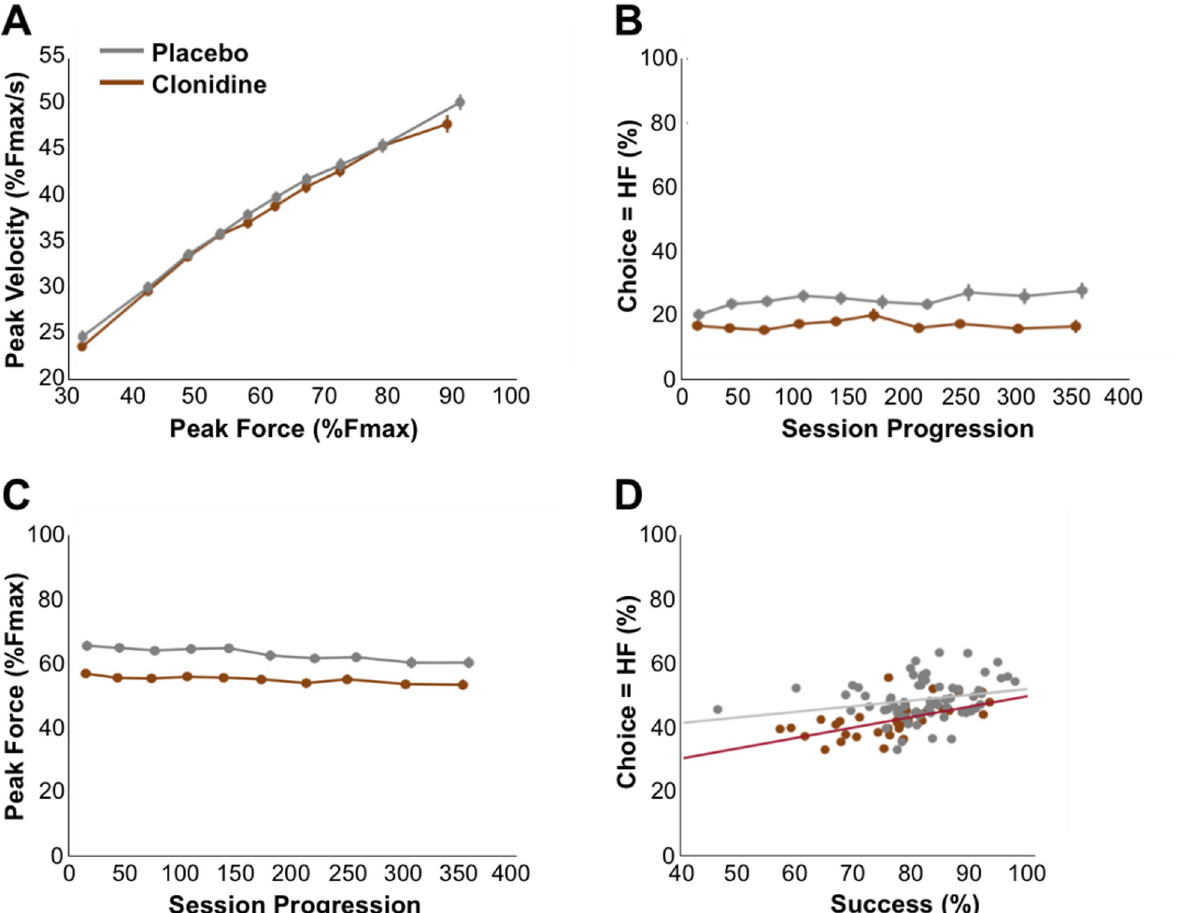
Fig 6. Specificity of the clonidine effect. Behavior of the monkeys in the placebo (gray) and clonidine (brown) conditions. Lines and dots represent group-level means (across monkeys) and error-bars represent SEM (across sessions). A . Relation between peak velocity and peak of the exerted force (commonly known as Fitts law). Clonidine did not affect this proxy for muscular contractility (clonidine = 4.32 ± 0.43, placebo = 4.14 ± 0.40, F (1,145) = 1.19, p = 0.27). B. Influence of session progression (trial number) on the percentage of high-required-force choices. Monkeys made less high- required-force choices overall, but the effect was constant over the session ( β = − 9.73 × 10 − 5 ± 9.13 × 10 − 5 , t (145) = − 1.06, p = 0.28). C. Influence of session progression (trial number) on exerted force. Exerted force was decreased under clonidine, but the effect of the drug was constant over the session ( p > 0.05). D. Proportion of high-required force choices as a function of success (proportion of correctly executed actions in the session, across sessions). There was no significant relationship between success rate and the proportion of high-force choices ( β = 0.04 ± 0.06, t (144) = 0.70, p = 0.17). Underlying data can be found in S1 Data. Fmax Maximal force,; HF, High